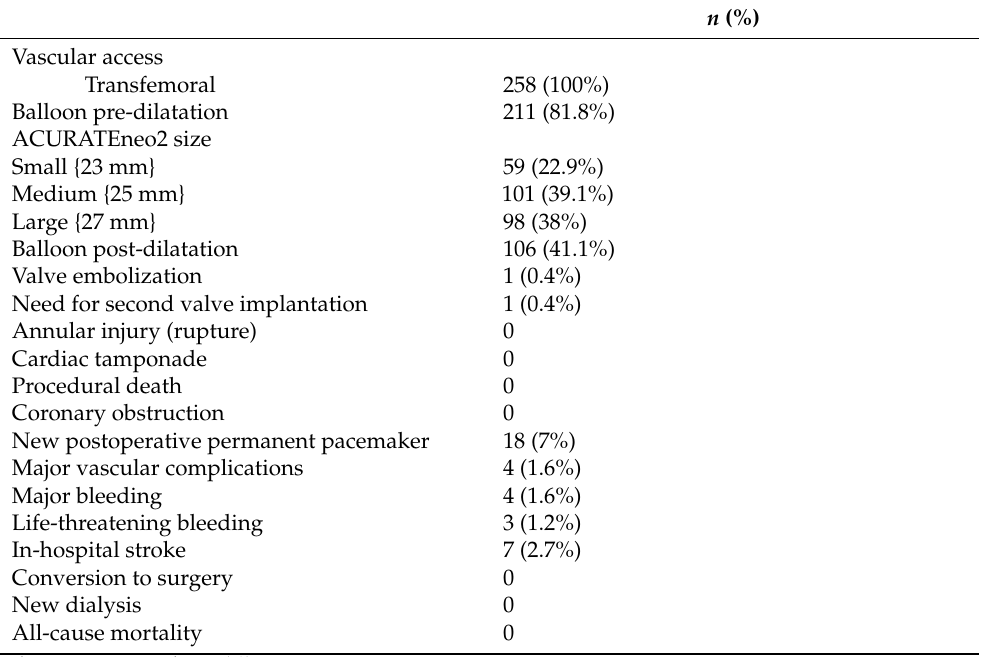
Table 2. Procedural characteristics and In-hospital